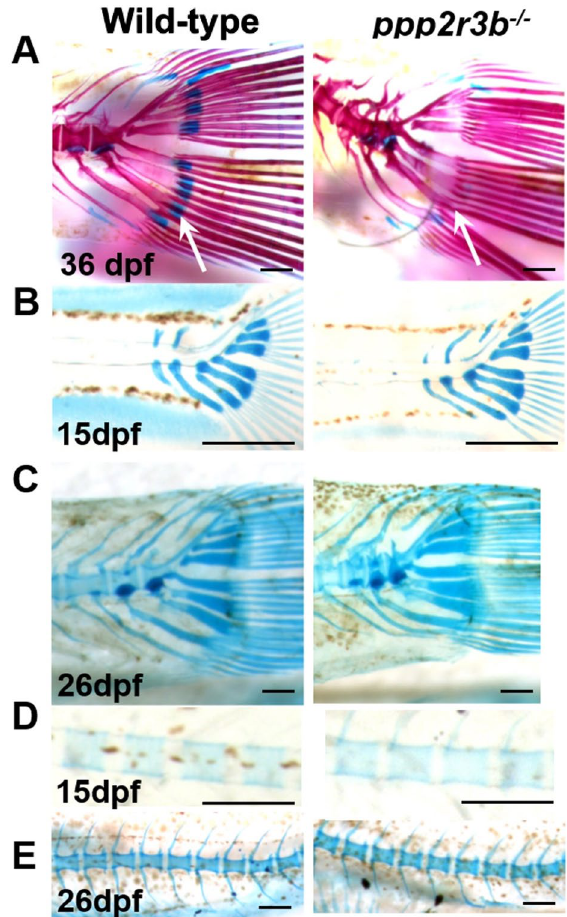
Figure 6. Temporal analysis of cartilage. Articular cartilage within the hypural bones is lost by 36 dpf ( A , arrows) in ppp2r3b −/− mutants but forms normally at 15 dpf ( B ) and is maintained until 26 dpf ( C ). Within the vertebral bodies, cartilage is induced and maintained normally ( D , E ) and is replaced by mineralised bone by 36 dpf ( A , and data not shown) in mutants. Scales bars are ( A ) 2.5 mm, ( B ) 0.5 mm, ( C ) 2.5 mm, ( D ) 150 µm, ( E ) 5